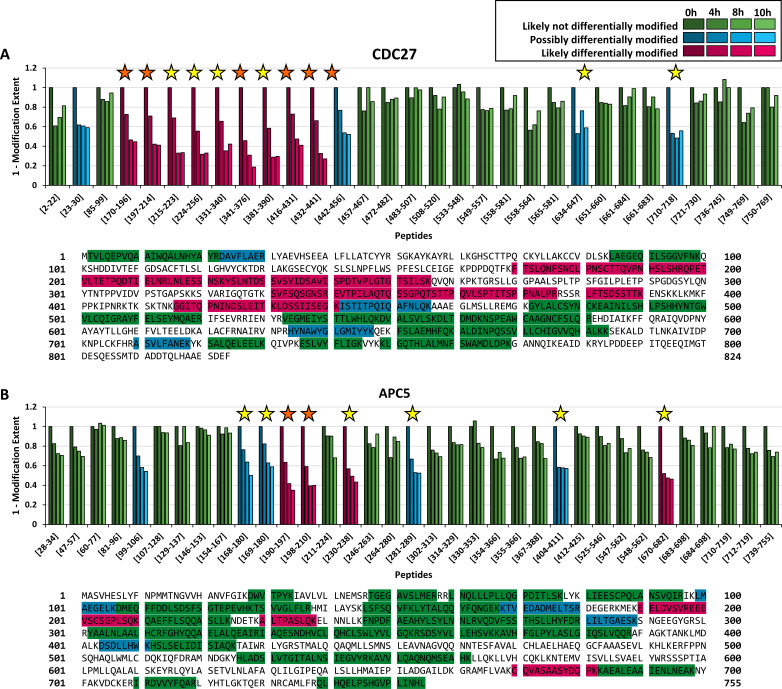
Benchmarking FLEXIQuant-LF with CDC27 and APC5.Peptide classification and extent of modification quantification of CDC27 peptides (A) and APC5 peptides (B) with protein sequences and measured peptides highlighted underneath. Green bars indicate peptides that were classified as likely not differentially modified (RM score ≥0.6), blue bars indicate peptides classified as possibly differentially modified (0.5 ≤ RM score<0.6) and magenta bars indicate peptides that were classified as likely differentially modified (RM score ≤0.5). Shading indicates timepoints from 0 hr (S phase; darkest shade) to 10 hr (brightest shade). Positions of peptides within the protein are given from the N- to C-terminus. Orange stars indicate modifications identified in the DDA dataset while yellow stars indicate modifications described in the literature. (A) FLEXIQuant-LF analysis of 32 CDC27 peptides after filtering classified nine and four peptides as likely and possibly differentially modified over the course of the experiment. We found PTM evidence for all peptides classified as likely differentially modified (for five in our DDA data and for all peptides online [see also Table 1]) as well as for three out of four peptides classified as possibly differentially modified (for one in our DDA data and all except of peptide [23-30] described online). (B) Out of 35 quantified peptides of APC5, four and five peptides were classified as likely and possibly differentially modified. We found evidence for the likely differentially modified peptides in our DDA data or as previously reported. Additionally, we found evidence for four out of five possibly differentially modified peptides online. Only for [99-106], we could not find any evidence for modification.